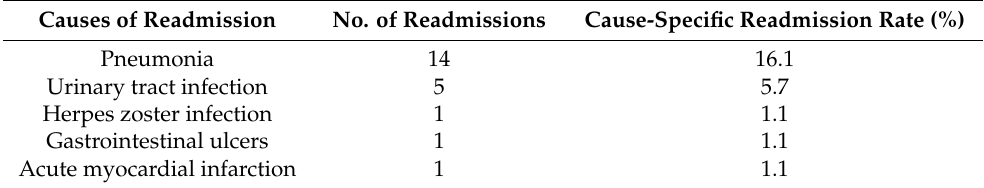
Table A2. Readmissions and cause-specific readmission rate before implementing LACE score-based predictive risk management tool to a home care patient cohort of a medical center affiliated home care unit in Taiwan in 2017. ( n = 87, 2017).